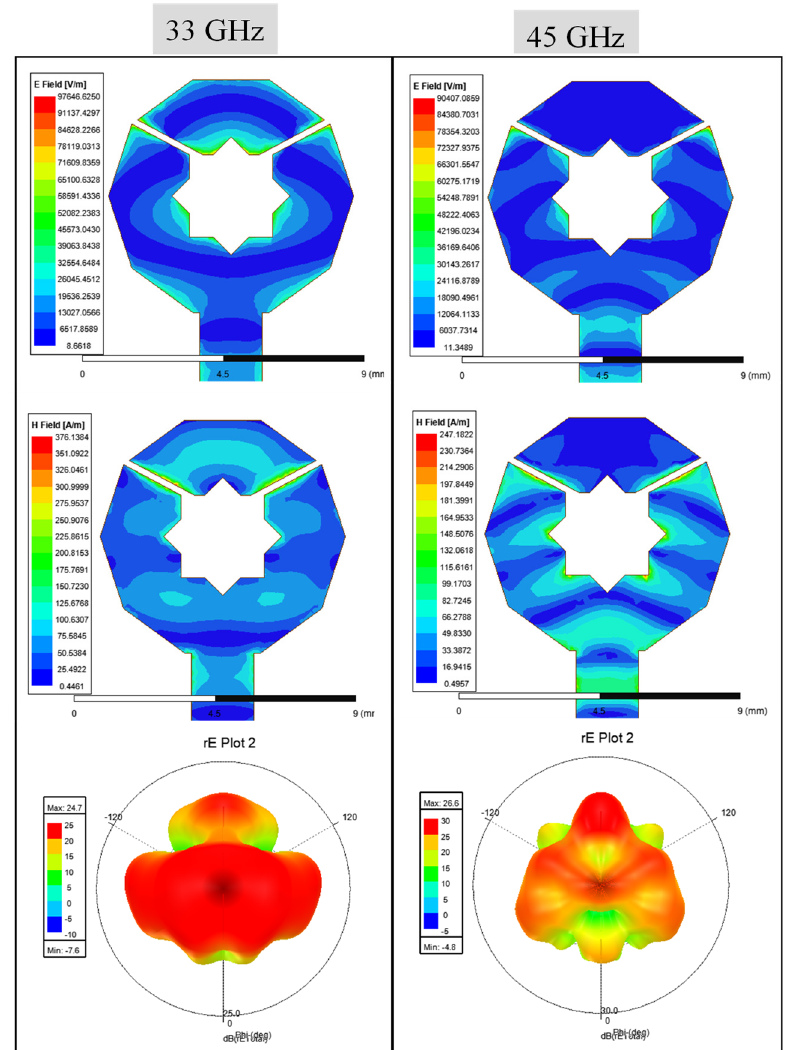
Figure 7. Magnetic and electric fields (in magnitude) and 3D—radiation patterns (in dB) at 33 and 45 GHz, respectively.